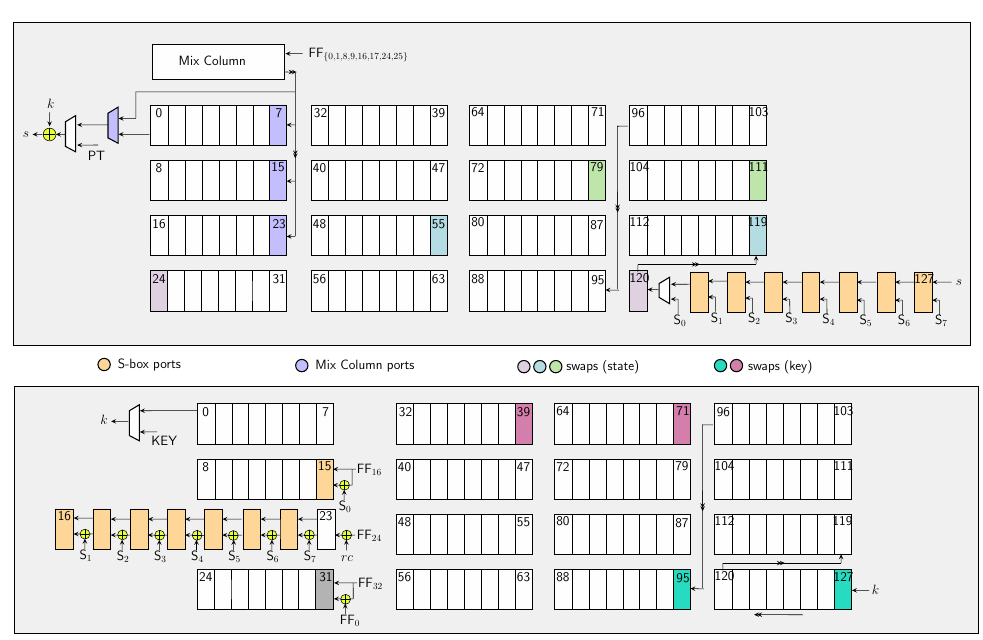
Figure 4: The state (above) and key (below) pipelines of AES-128 encryption with colored scan flip-flops. S-box output ports are denoted with S 0 || S 1 || . . . || S 7